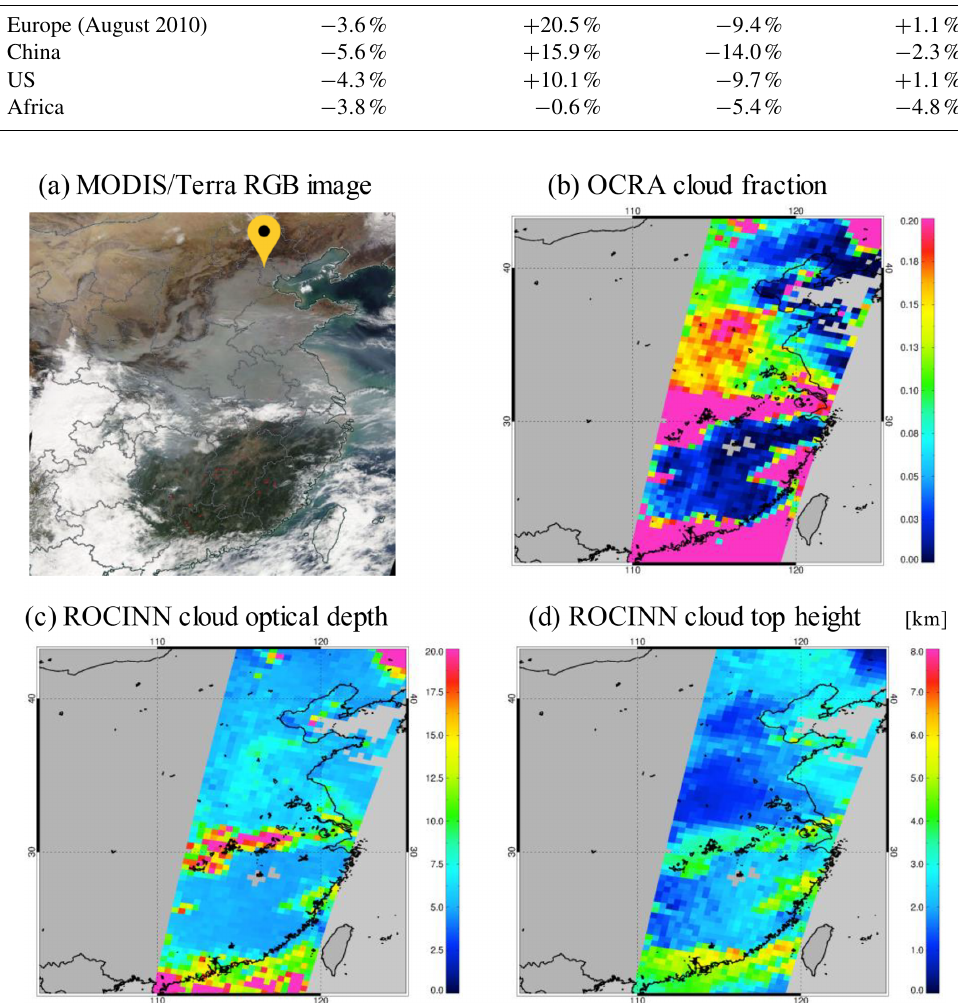
Figure 14. A MODIS/Terra RGB image (a) , GOME-2 OCRA cloud fraction (b) , GOME-2 ROCINN_CAL cloud optical depth (c) , and GOME-2 ROCINN_CAL cloud top height (d) over eastern China on 21 November 2013. Cloud observations with a fitting rms greater than 1 × 10 − 4 or a number of iterations greater than 20 are filtered out. The yellow location symbol in the MODIS image indicates Xianghe station (39.75 ◦ N, 116.96 ◦